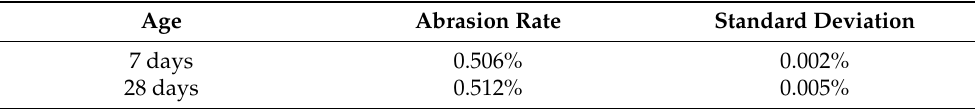
Table 5. Abrasion test results.